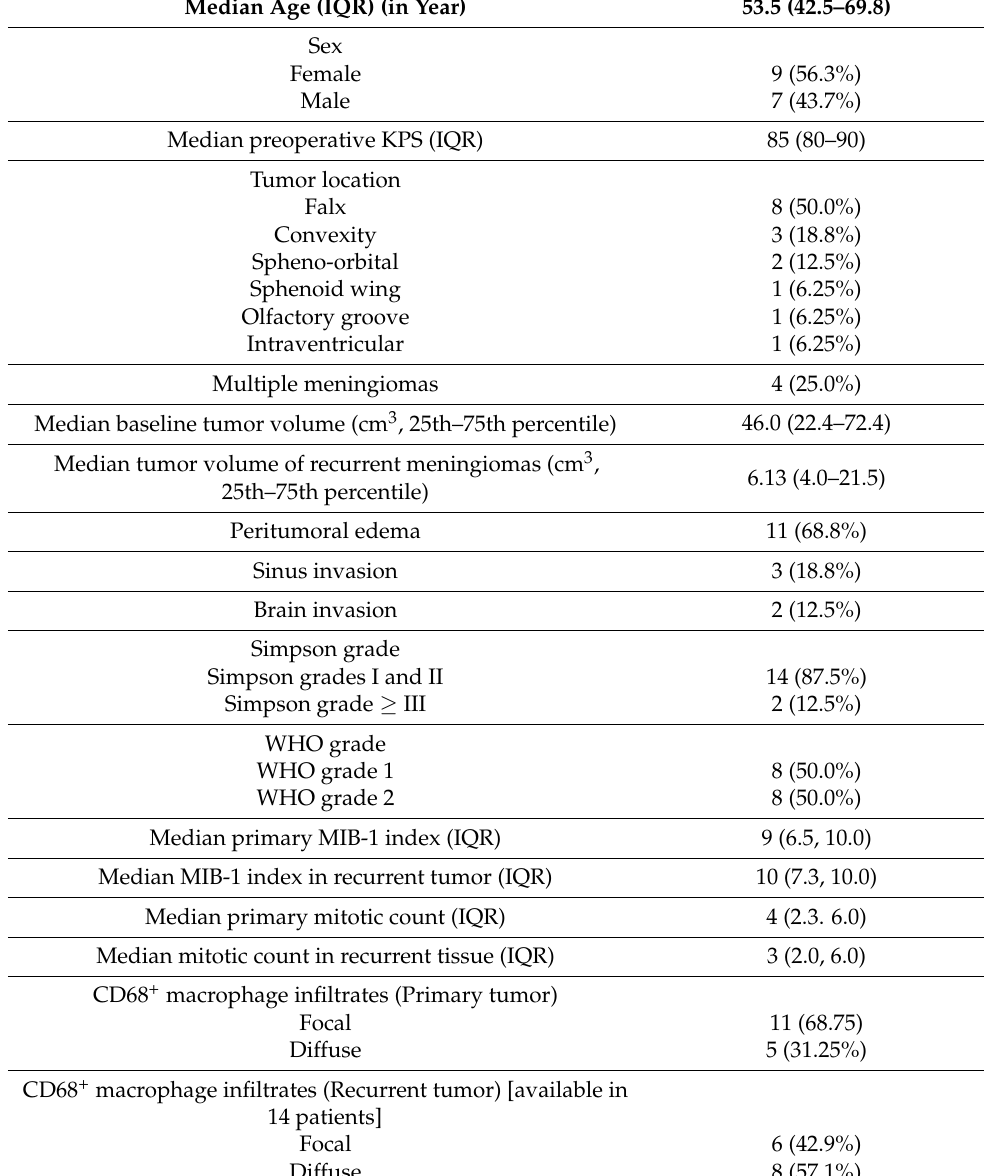
Table 1. Patient characteristics ( n =